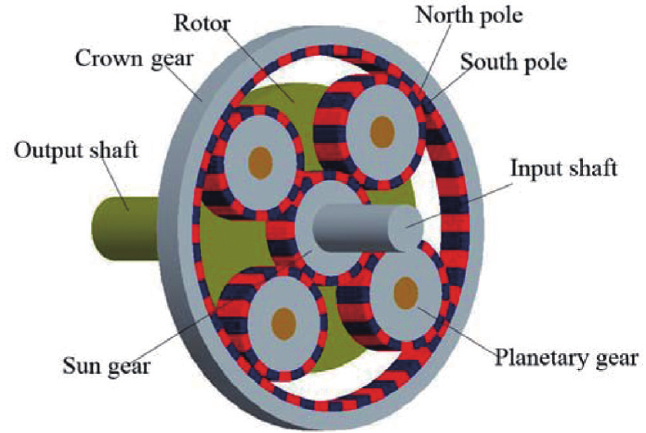
Fig. 1. The magnetic planetary drive.